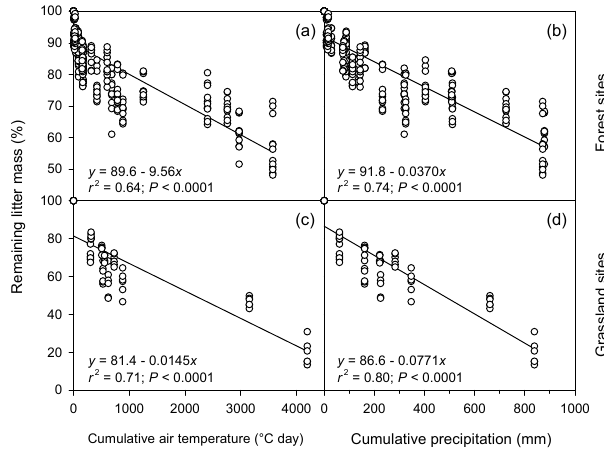
Figure 2. Average remaining biomass during first year decomposi- tion of leaf litter of four tree species in four forest sites (a, b) and grass litter from two species in two grasslands (c, d) across Eu- rope (see Table 1 for details). The cumulative air temperature is the sum of daily average temperatures above 0 ◦ C from the beginning of the decomposition period until the date of litter collection for every litter bag. The cumulative precipitation is the sum of daily precipitation (in mm) from the beginning the decomposition period until the date of litter collection. The solid lines represent the Pear- son’s linear regression best fit ( n = 336 for forest sites and n = 72 for grassland sites).